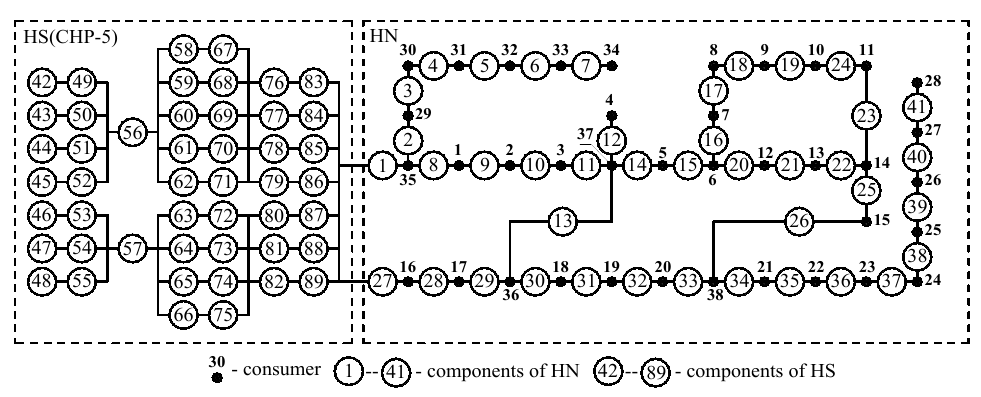
Fig. 4. Scheme of DHS in Shelekhov city for the reliability